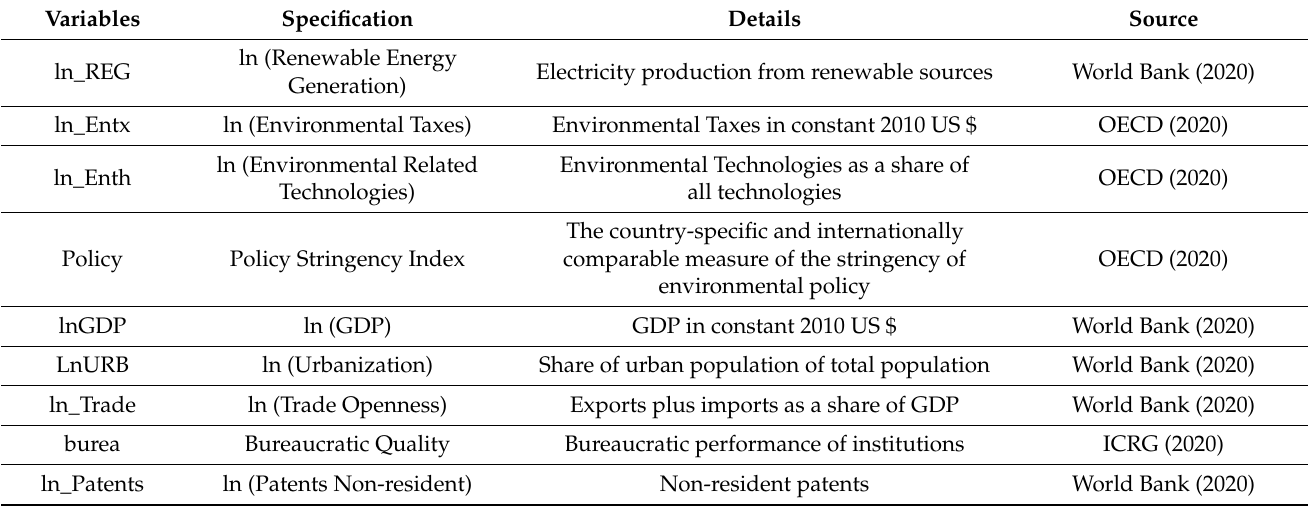
Table 1. Variables’